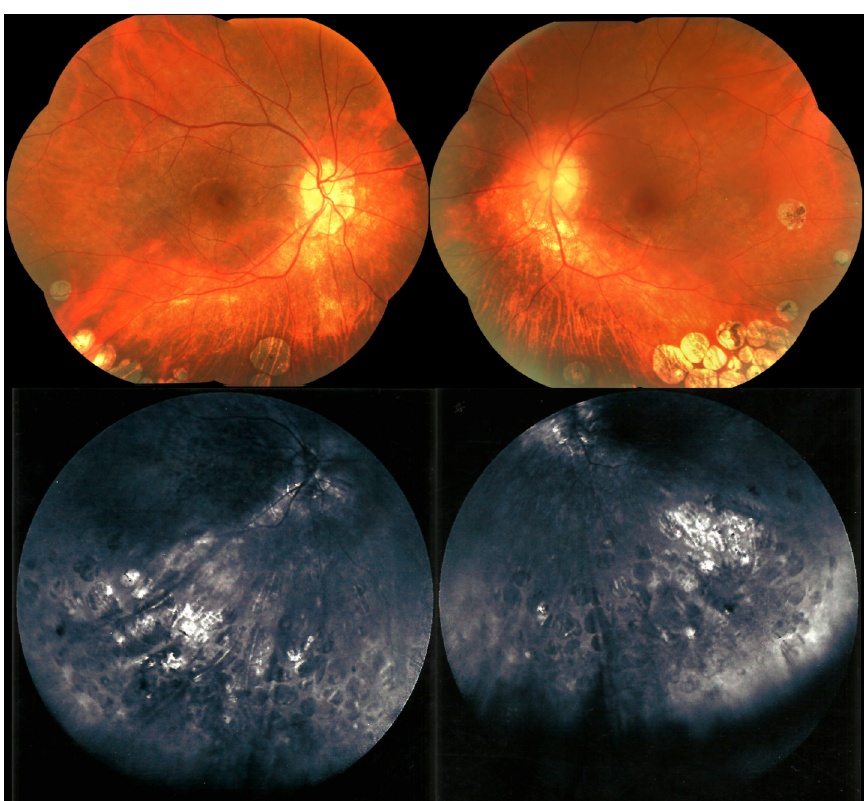
Figure 1: Fundus photographs showing patches of chorioretinal atrophy in the inferior retina of both eyes